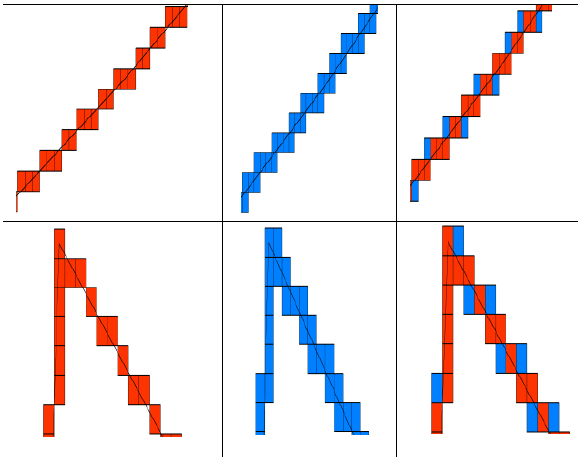
Table 2. Comparison table of the detail effect in the rectangle grid